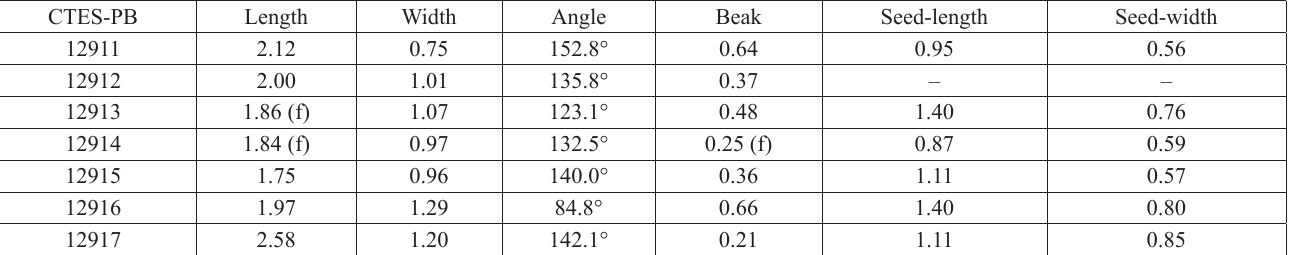
Table 1. Characters and measurements (in mm) of all specimens analyzed in this work. “–”, the structure was not observable; (f), the structure was